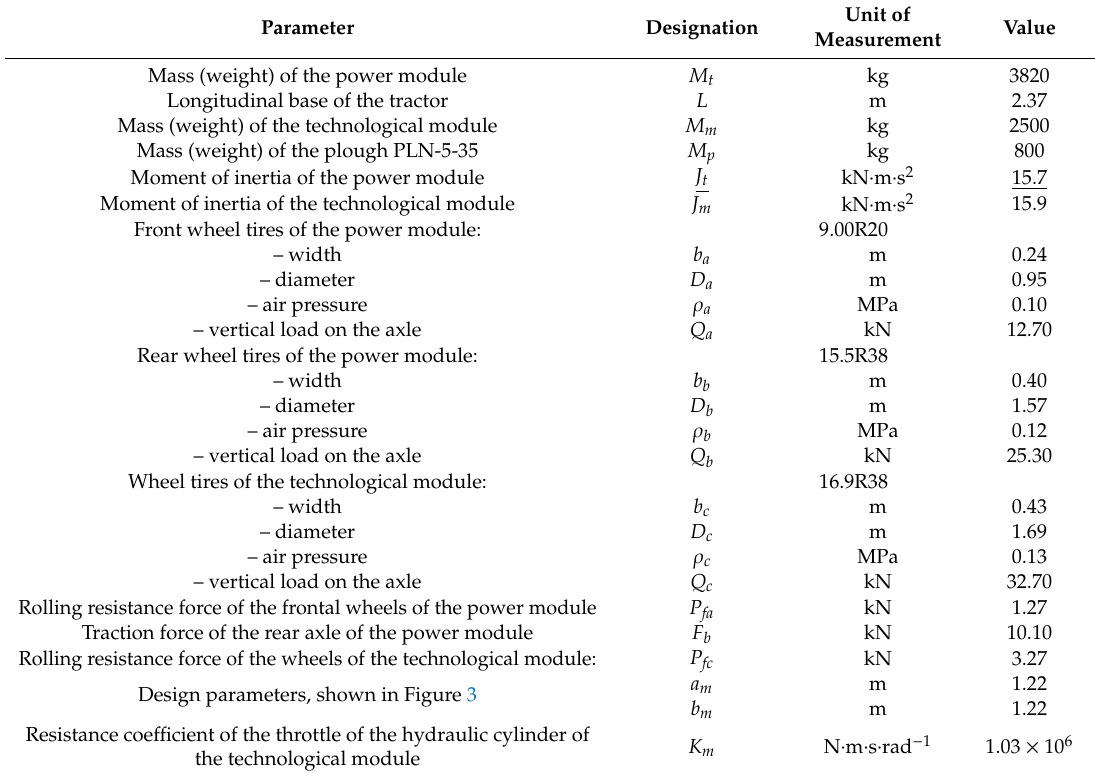
Table 1. Technical characteristics of a modular-type machine-and-tractor aggregate with a plough.